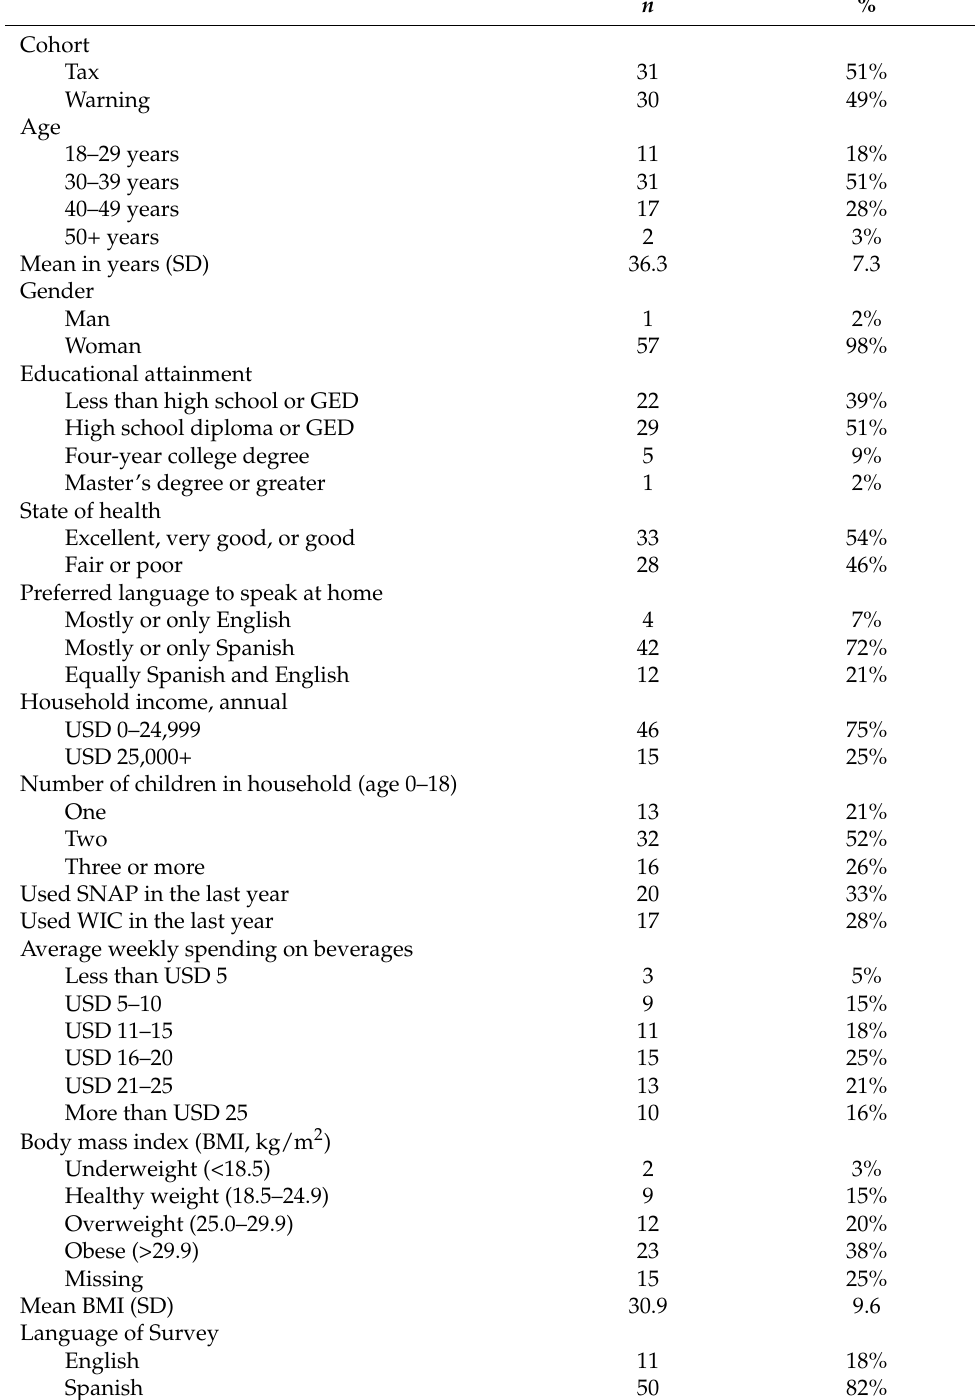
Table 1. Characteristics of study participants in a naturalistic store